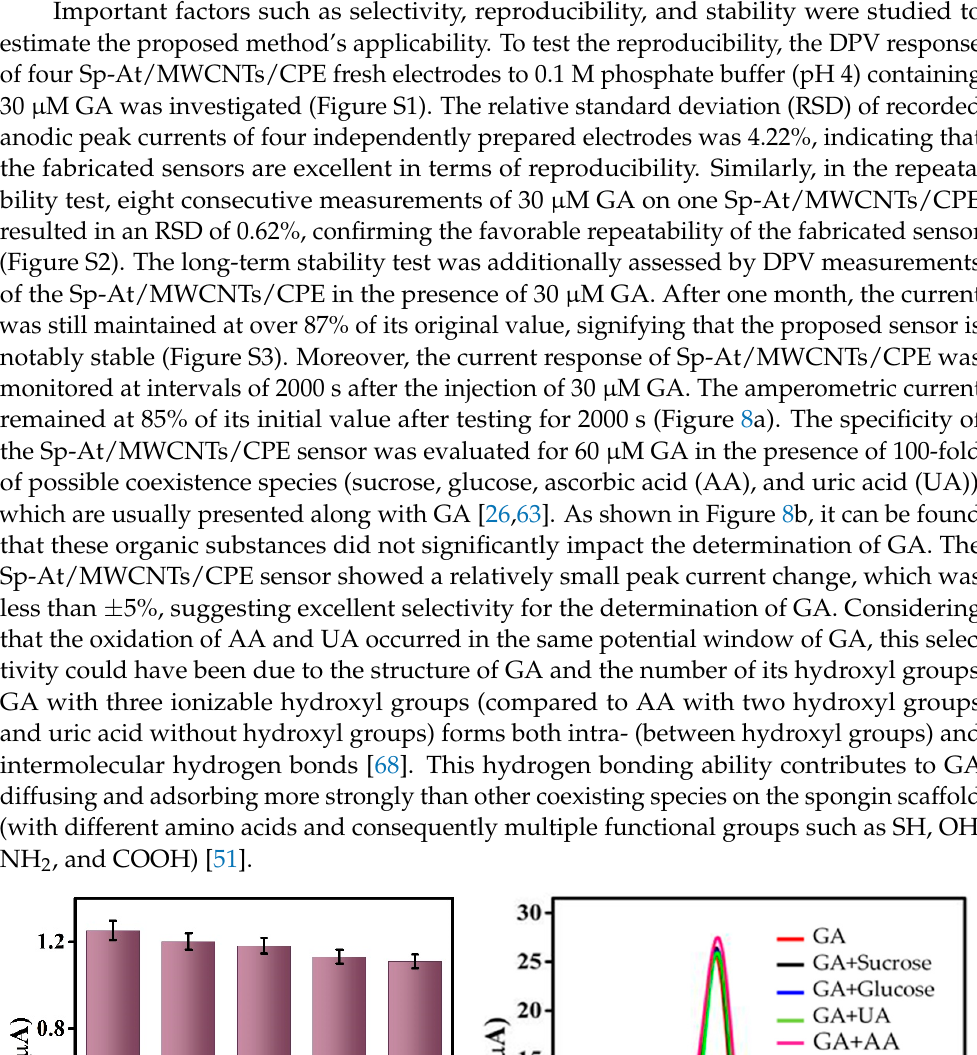
Table 3. Results of the analysis of GA in black/green tea and red wine. Sample